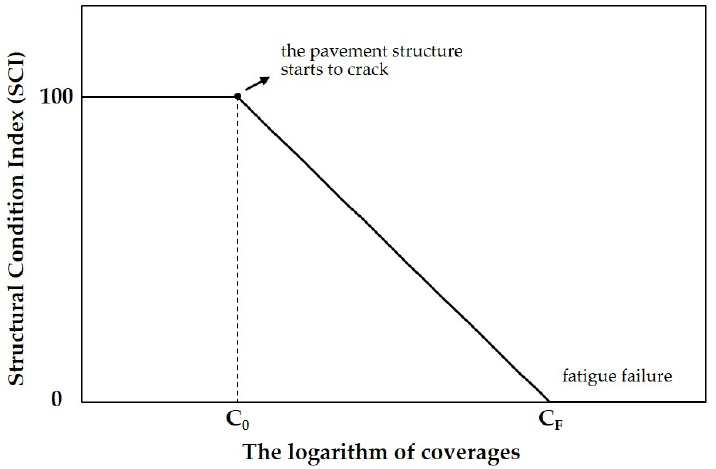
Figure 2. The relationship between SCI and the logarithm of coverages.